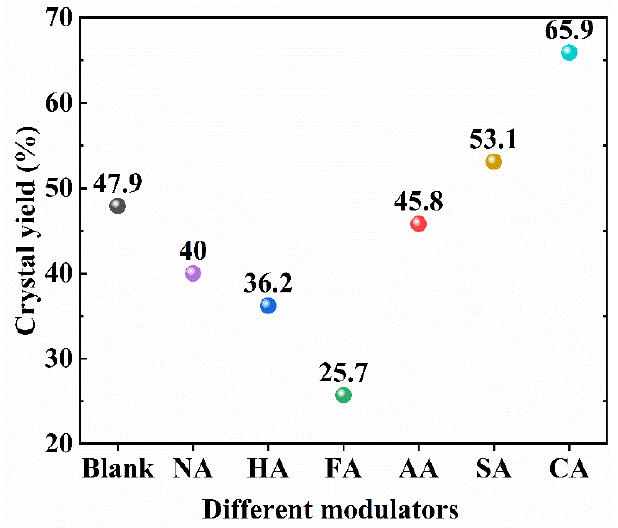
Figure 3. Crystal yield of the blank sample and MIL-101 (Cr, Sn) modulated by different acid modulators.